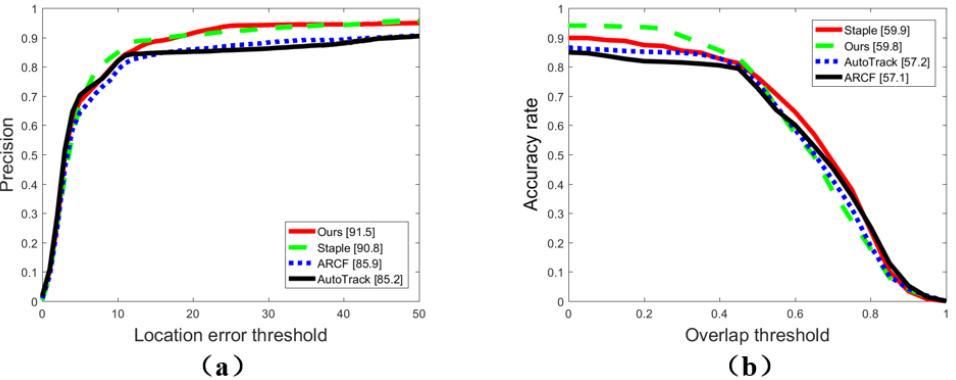
Figure 4. Comparison of the total precision and total accuracy under different correlation filtering algorithms. ( a ) is the total precision of different algorithms, ( b ) is the total accuracy of different